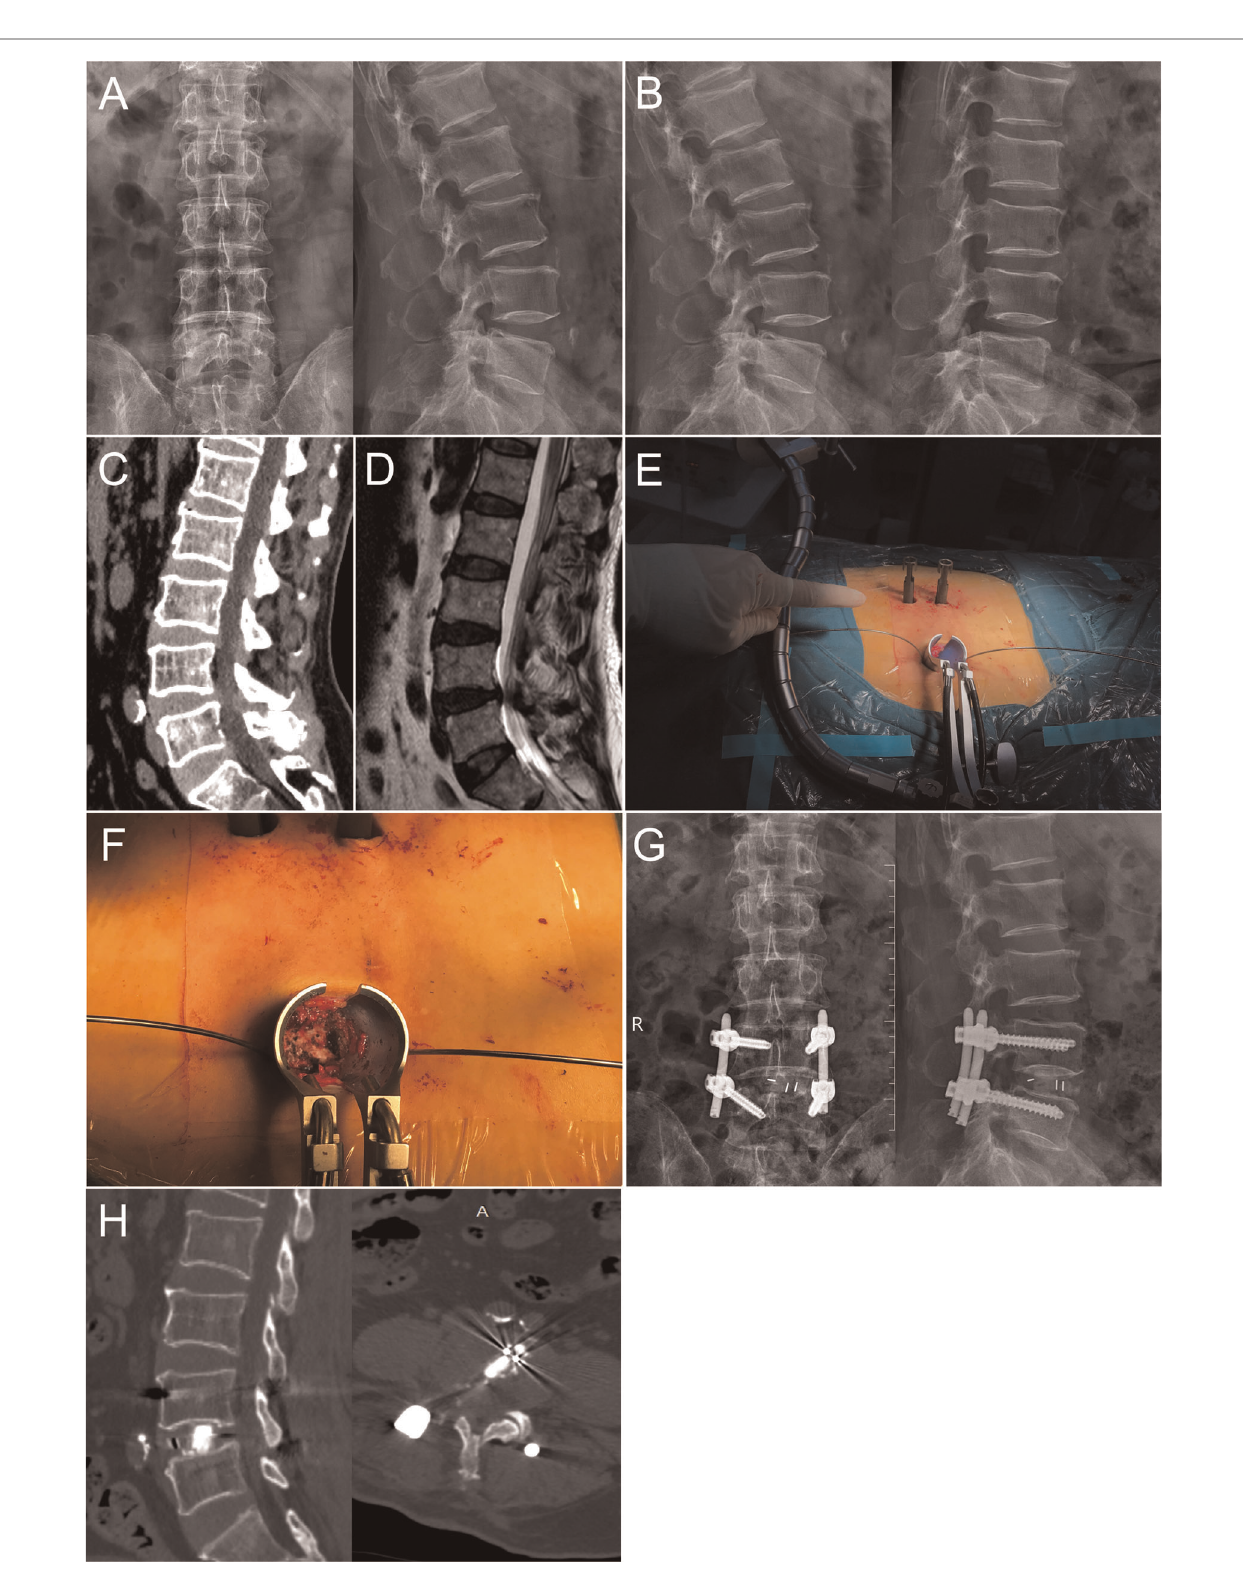
FIGURE 2 | A 68-year-old male with L4-5 LSS in the MIS-TLIF group. ( A – D ) Preoperative X-ray, CT, and MRI showed the condition of the symptomatic segment, and the dynamic fl exion-extension radiographs showed L4 instability; ( E ) The tubular retractor system was placed; ( F ) Decompression of nerve root and dural sac were performed under direct visualization; ( G,H ) X-ray and CT showed the posterior instrument and the cage was